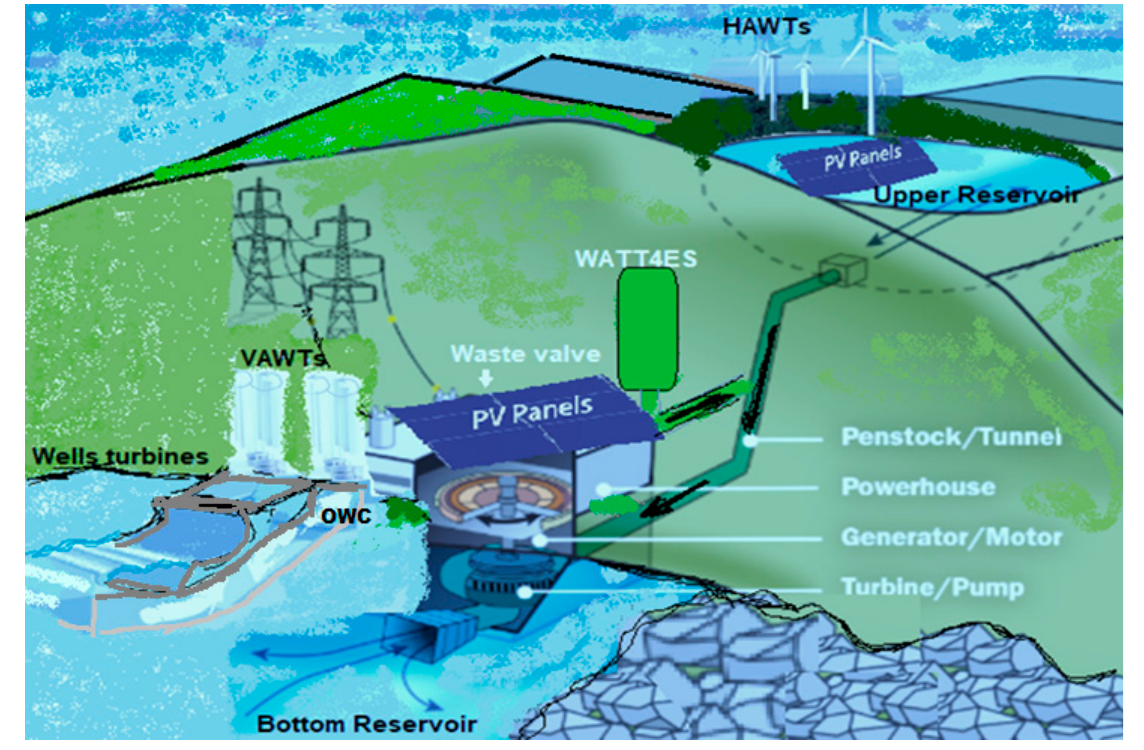
Figure 24. Hy4REN in a nearshore idealization.